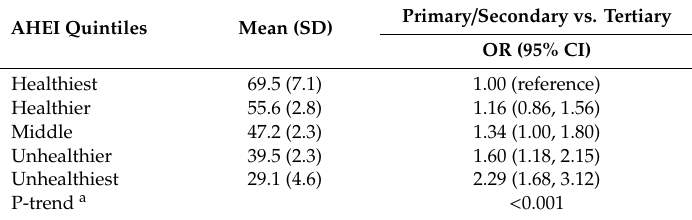
Table 2. Association of educational level with quintiles of the Alternate Healthy Eating Index, menuCH, Switzerland, 2014–2015.